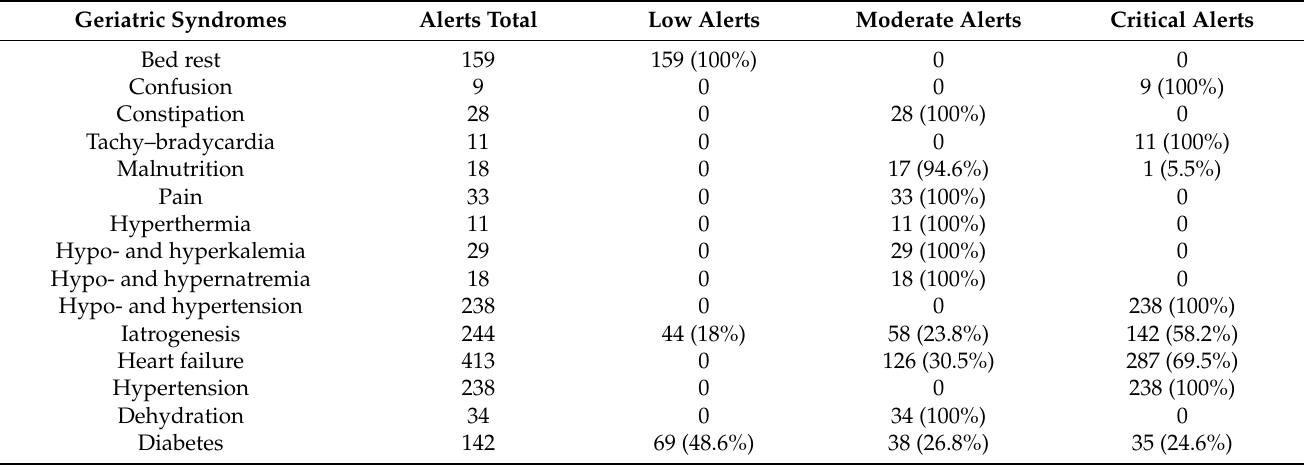
Table 5. Total alerts emitted per risk group and geriatric risk (“low”, “medium”, and “critical”).